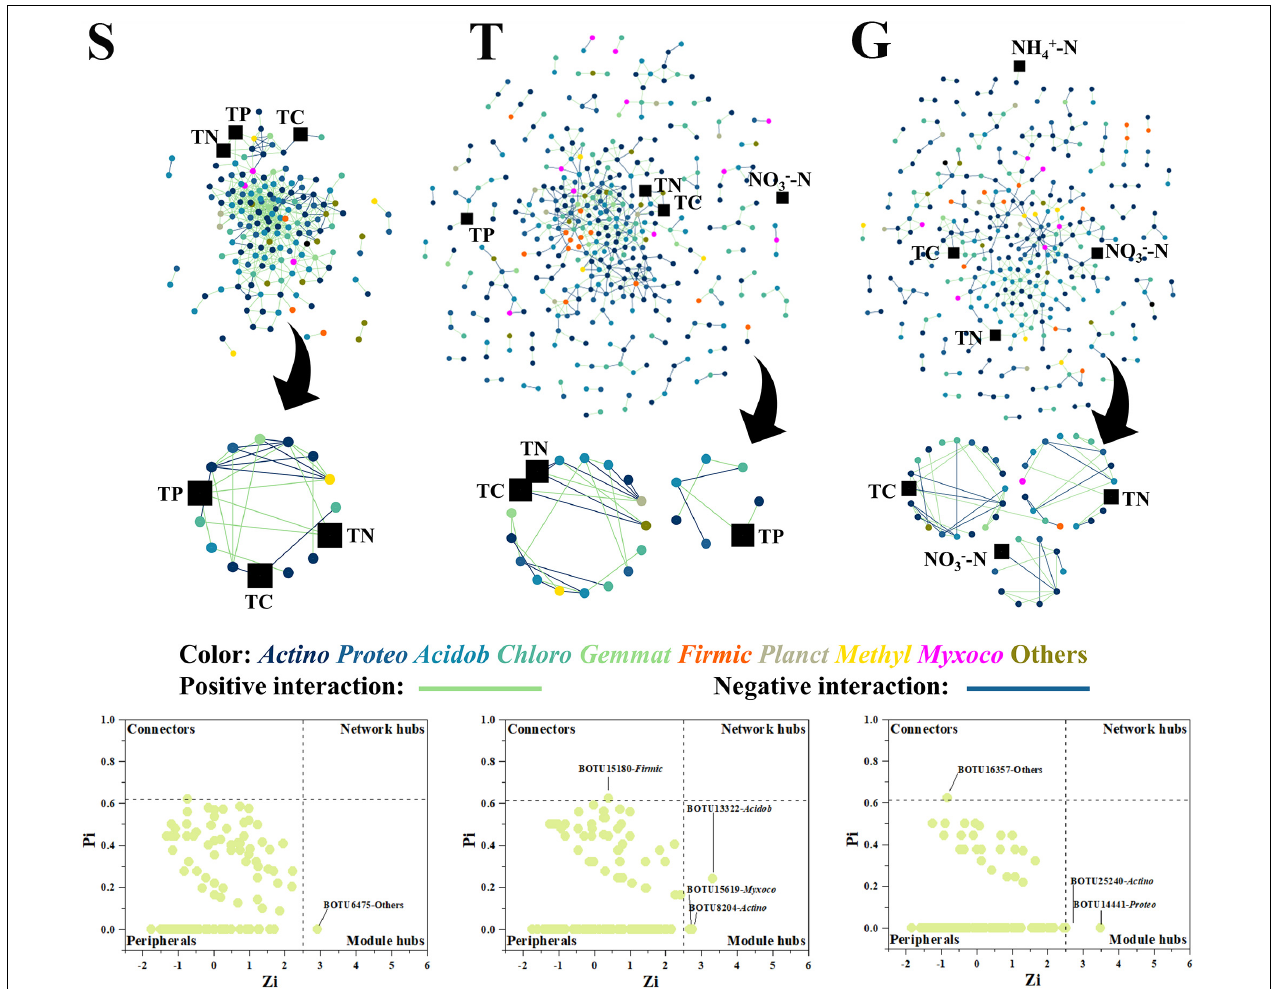
FIGURE 3 | The bacterial network, with functional modules and key node composition. The phylogenetic identity (phylum level) of nodes is depicted by different colors; positive and negative interactions are depicted as green and blue lines, respectively. The environmental factors are depicted as black squares. The “ Actino ” is the abbreviation for “Actinobacteria” and similarly to other bacterial